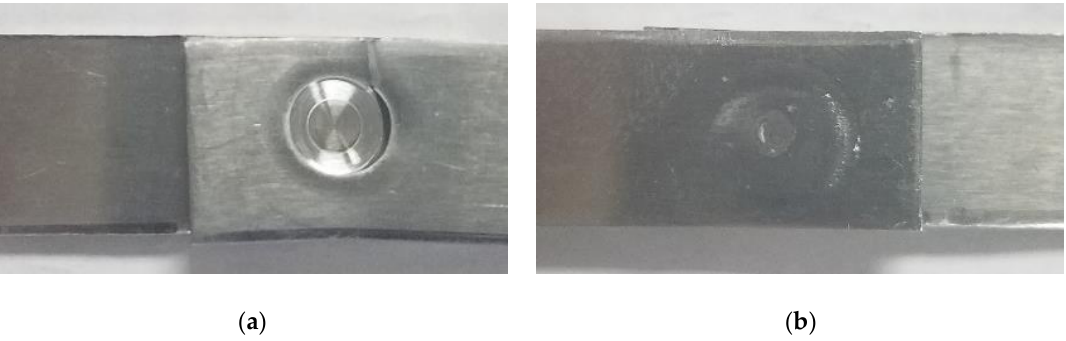
Figure 14. Top-sheet-breakdown failure of the 2D-Pitch 1.5D-EM coupon: ( a ) top view of nugget pullout; ( b ) bottom view of nugget pullout. Notes: D = 7 mm (Spot Weld Diameter); EM = Edge Margin; pitch = Spot Weld Spacing.